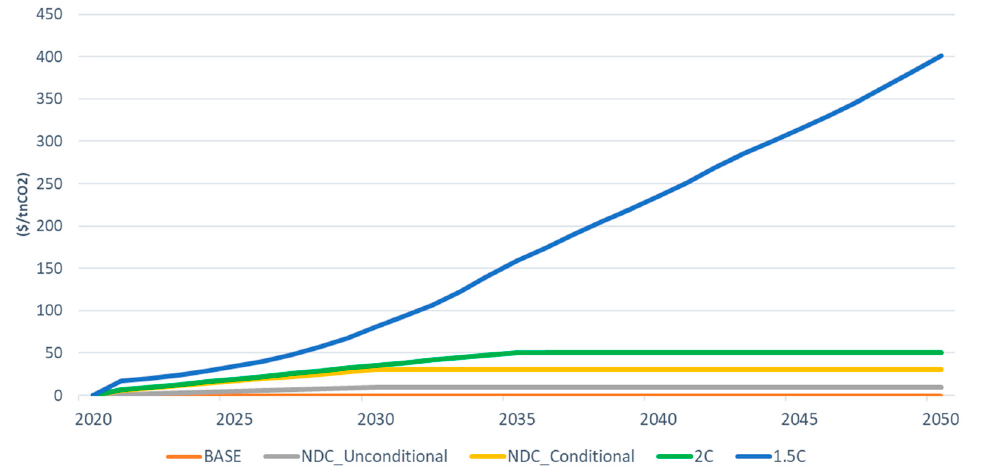
Figure 11. Tunisia’s carbon price projections from 2020–2050 (in USD/tnCO2), Source: MENA-EDS Model.